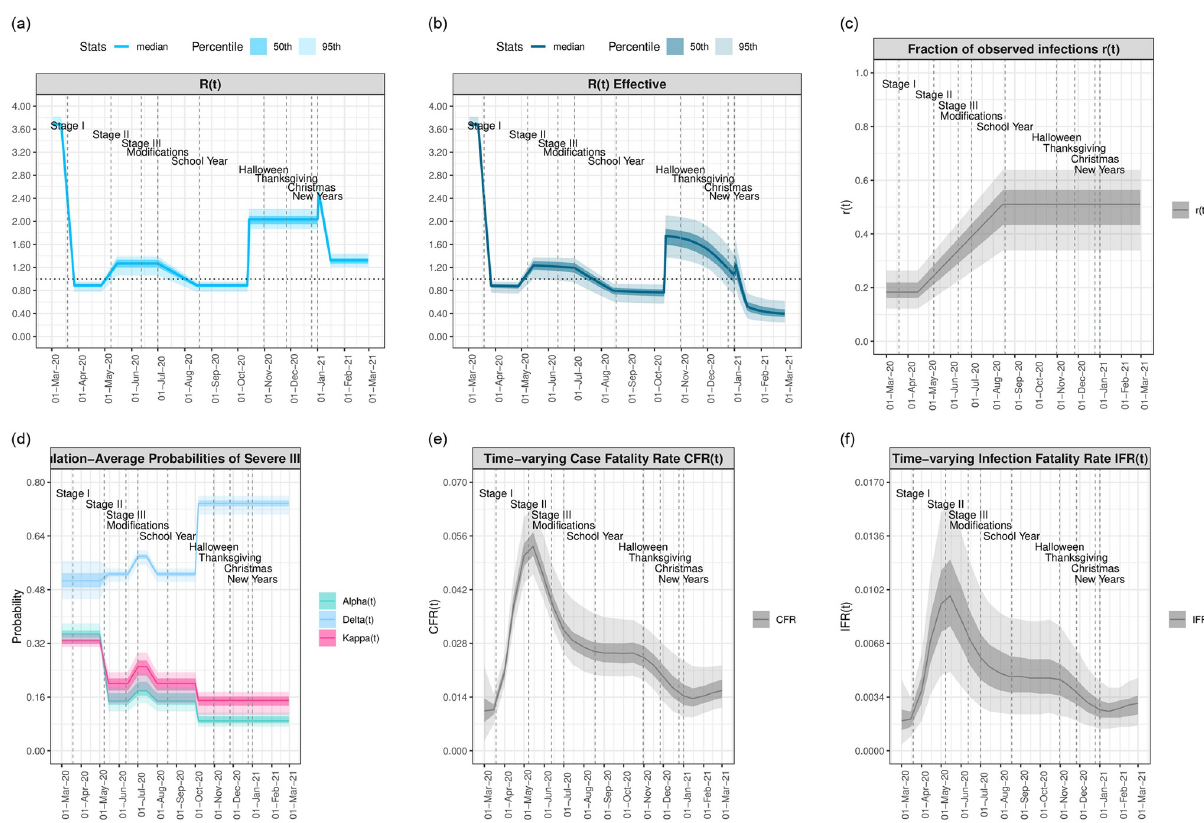
Fig 4. Timeseries of model-estimated parameters relative to key dates and COVID-19 policy decisions in LAC. Model-estimated median curves are plotted along with the 50th% (dark shading) and 95% CI (light shading). ( a ) R reproduction number. ( c ) r t , proportion observed infections. ( d ) α t , the probability of hospitalization given infection; κ t , probability of ICU admission given hospitalization; and δ , probability of death given admission to the ICU. ( e ) Population-average case fatality rate, CFR t infection fatality rate, IFR t